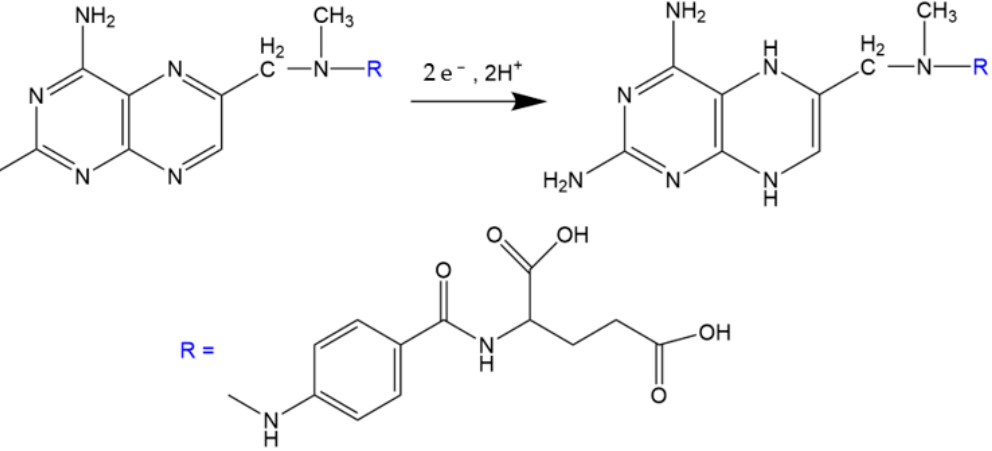
Figure 4. Possible mechanism involving the electroreduction of methotrexate.